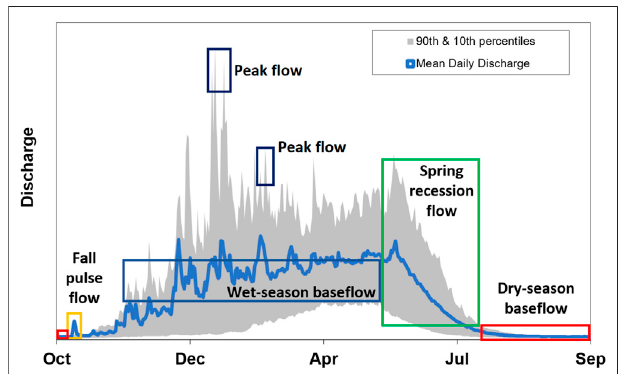
FIGURE 2 | Functional fl ow components for California depicted on a representative hydrograph. Blue line represents median (50th percentile) daily discharge. Gray shading represents 90th – 10th percentiles of daily discharge over the period of record. Adapted with permission from Yarnell et al.